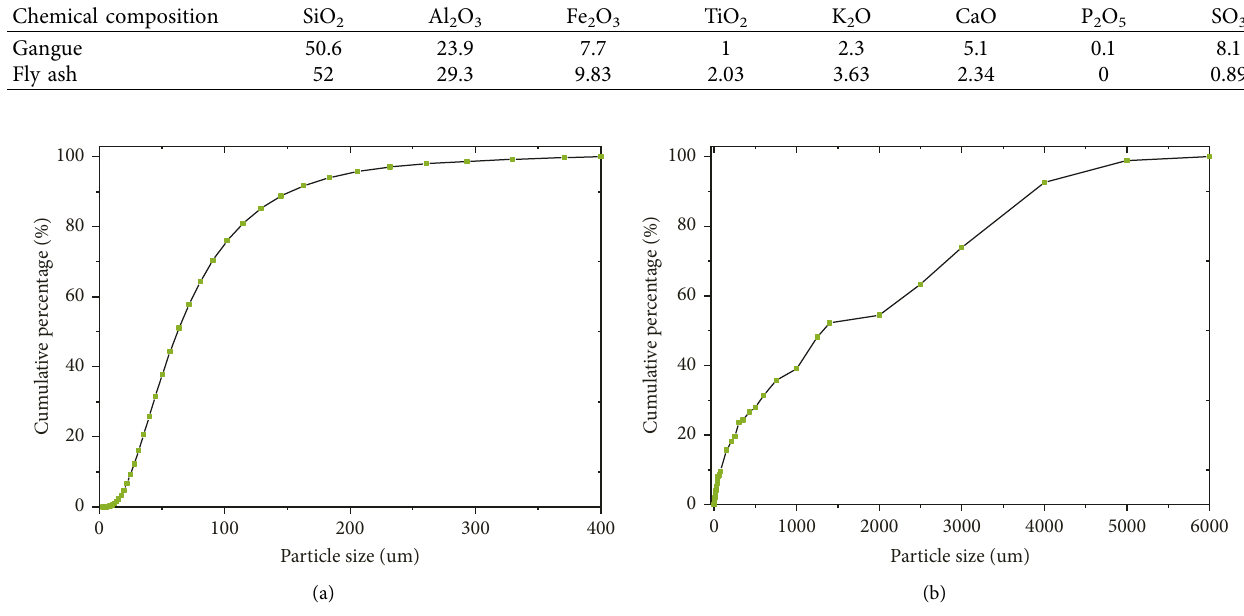
Figure 2: Cumulative distribution of particle size. (a) Fly ash. (b) Gangue. Table 2: Particle size distribution of coal gangue and fly ash mixed in different